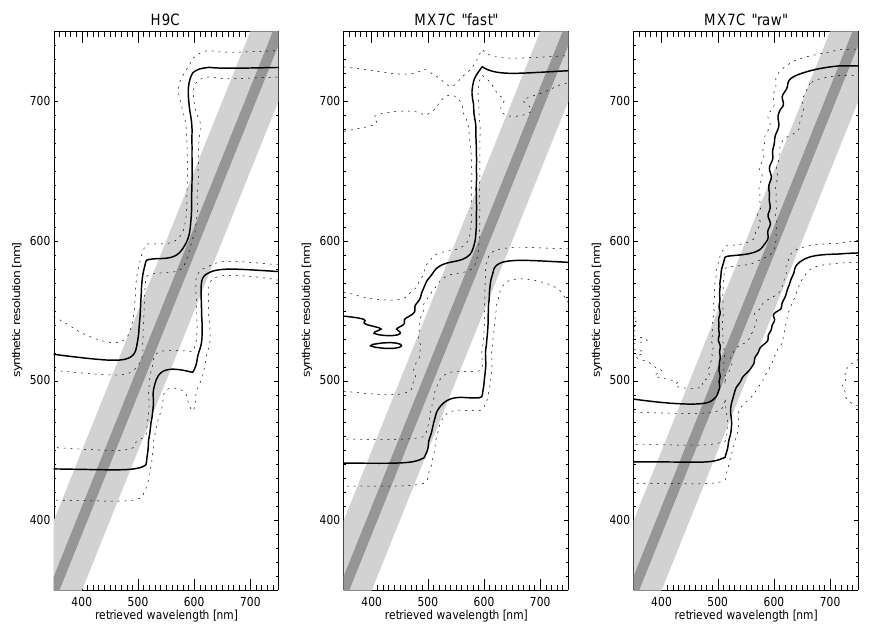
Figure 11. Contour plots of synthetic bandwidth ( y axis) variation with retrieved wavelength ( x axis). All functions are normalized to unit peak; FWHM is indicated by the solid contour. Light and dark diagonal shading corresponds to an unbiased detector with FWHM of 100 and 20nm respectively.